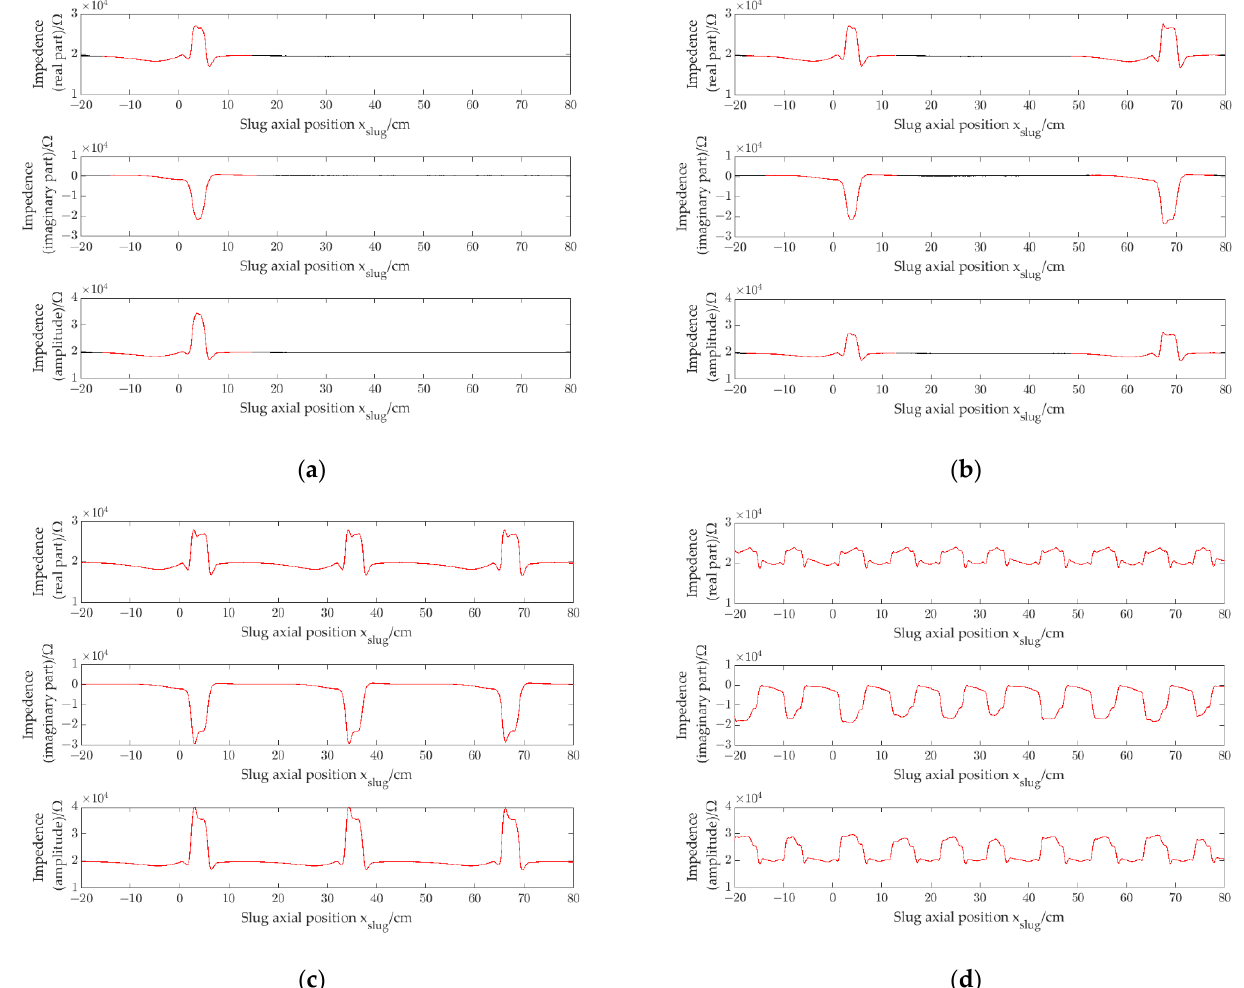
Figure 12. Impedance signals of slug flow, i.d. = 3.02 mm: ( a ) single slug; ( b ) signal separation distance is 64 cm ( ρ re = 0.95, ρ im = 0.98 and ρ am = 0.95); ( c ) signal separation distance is 31 cm ( ρ re = 0.94, ρ im = 0.96 and ρ am = 0.94); ( d ) signal separation distance is 11 cm ( ρ re = 0.39, ρ im = 0.53 and ρ am = 0.39 )